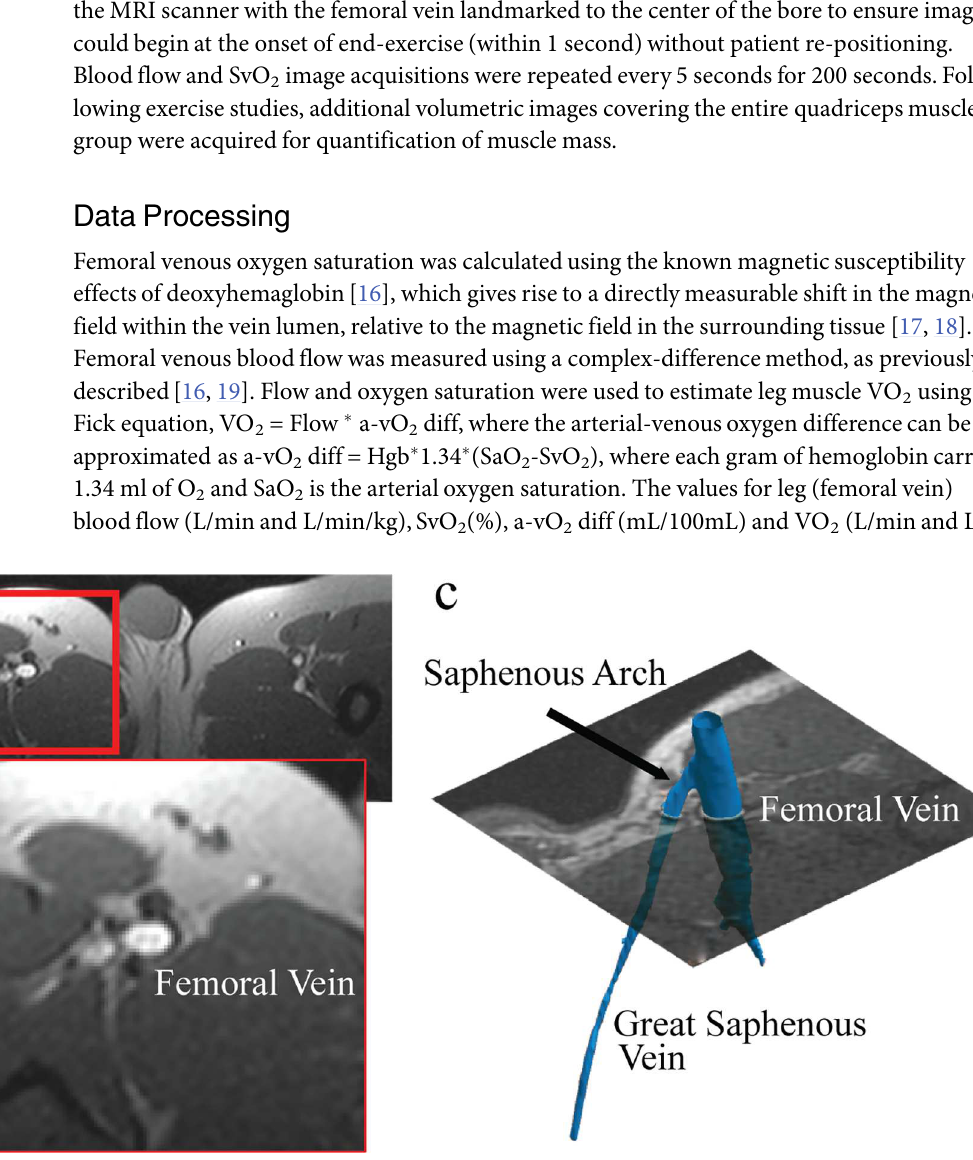
Fig 1. Femoral vein slice prescription. ( a ) Anatomic image showingthe slice orientation, perpendicular to the targeted femoral vein, with a close-up view in ( b ). The location of the slice, relative to the femoral vein and great saphenous vein is shown in ( c ), with targeting of the femoral vein prior to the